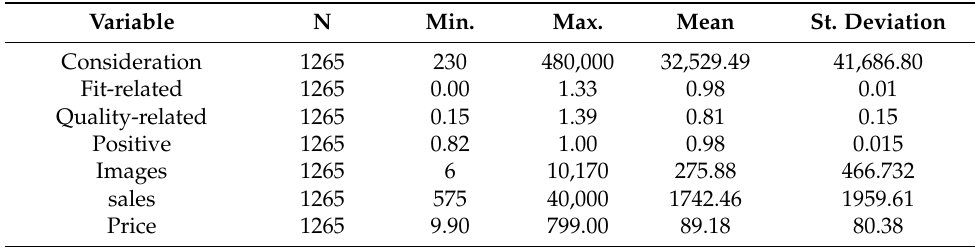
Table 2. Descriptive statistical analysis of